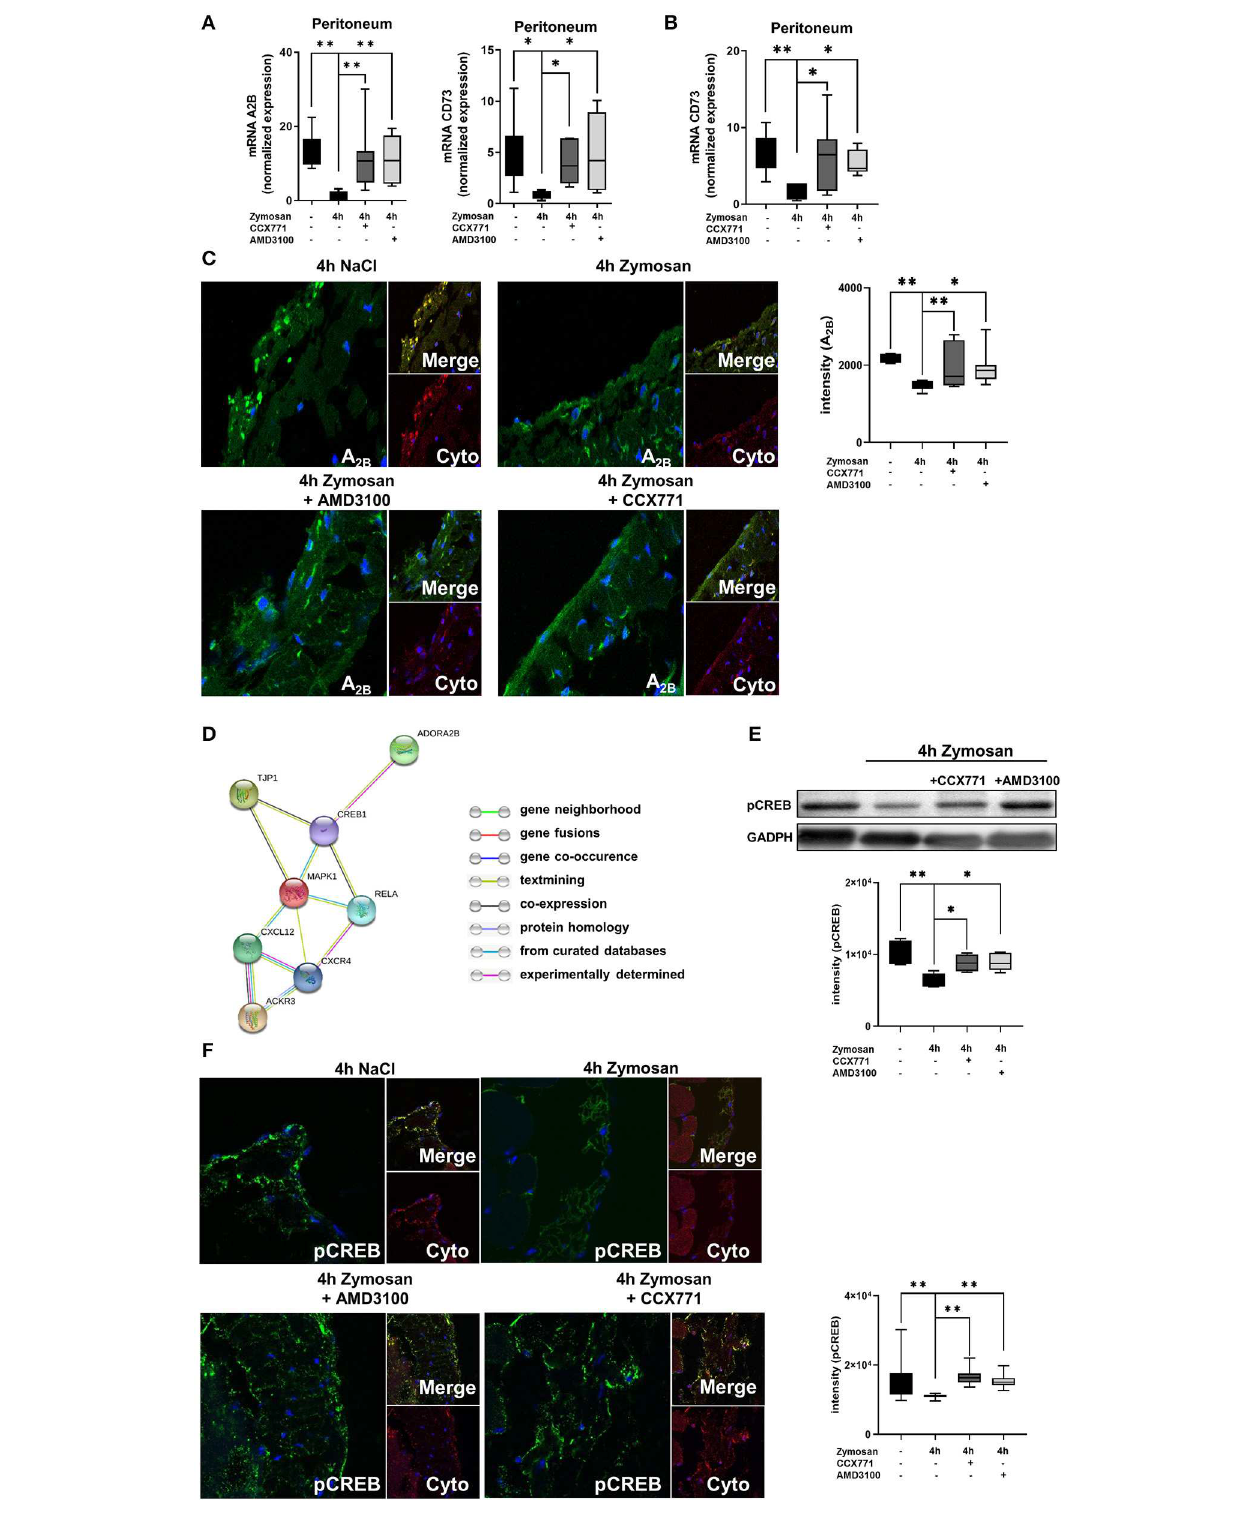
FIGURE 3 | Link between the SDF-1-CXCR4-CXCR7-axis and the adenosine receptor A 2B . (A) Expression levels of adenosine receptor A 2B and CD73 in peritoneal tissue 4h after NaCl or zymosan with or without AMD3100 or CCX771 in wild type (WT) animals ( n = 7–8). (B) Gene expression of CD73 in the peritoneum of A 2B –/–